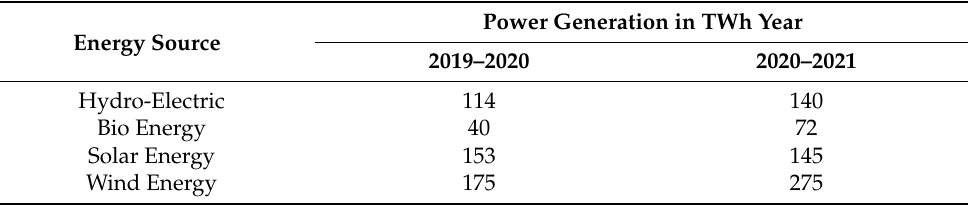
Table 1. Power generation from renewable energy resources worldwide [29,30]. Power Generation in TWh Energy Source